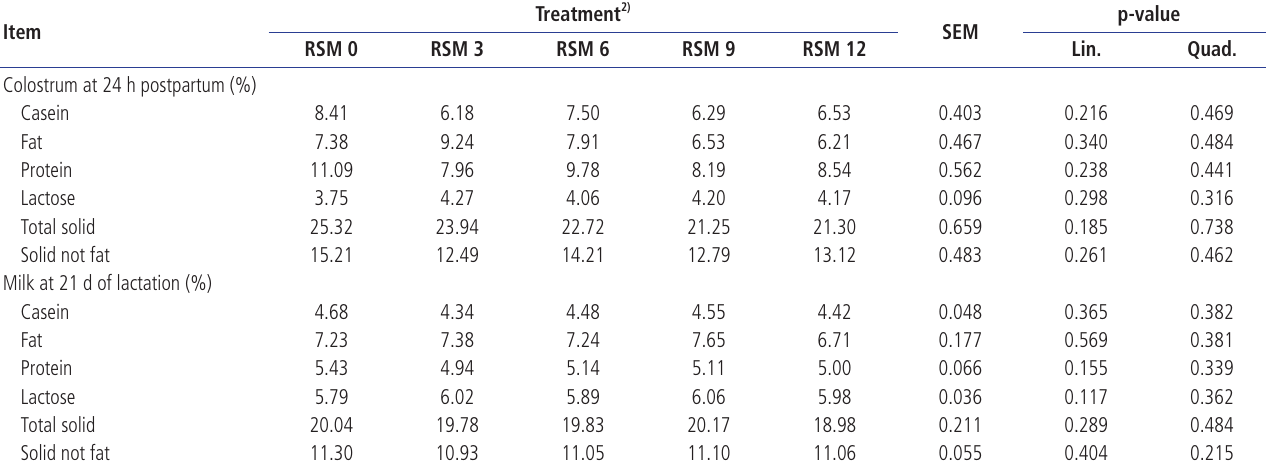
Table 9. Effect of rapeseed meal (RSM) supplementation levels in gestation diets on milk composition of sows